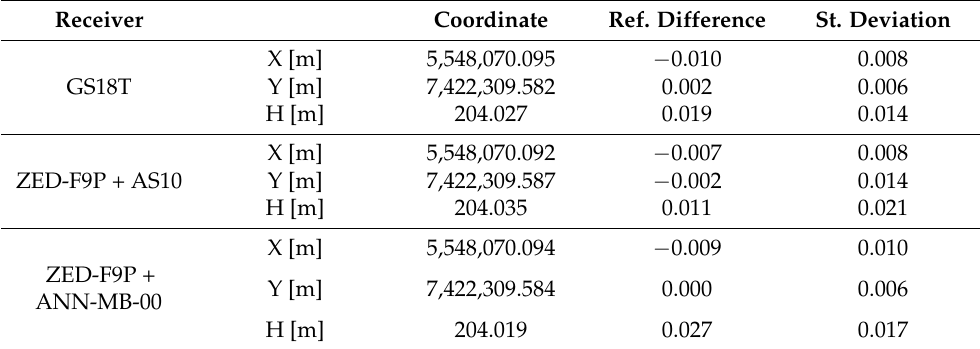
Table 2. Measurement results on Pt 1.